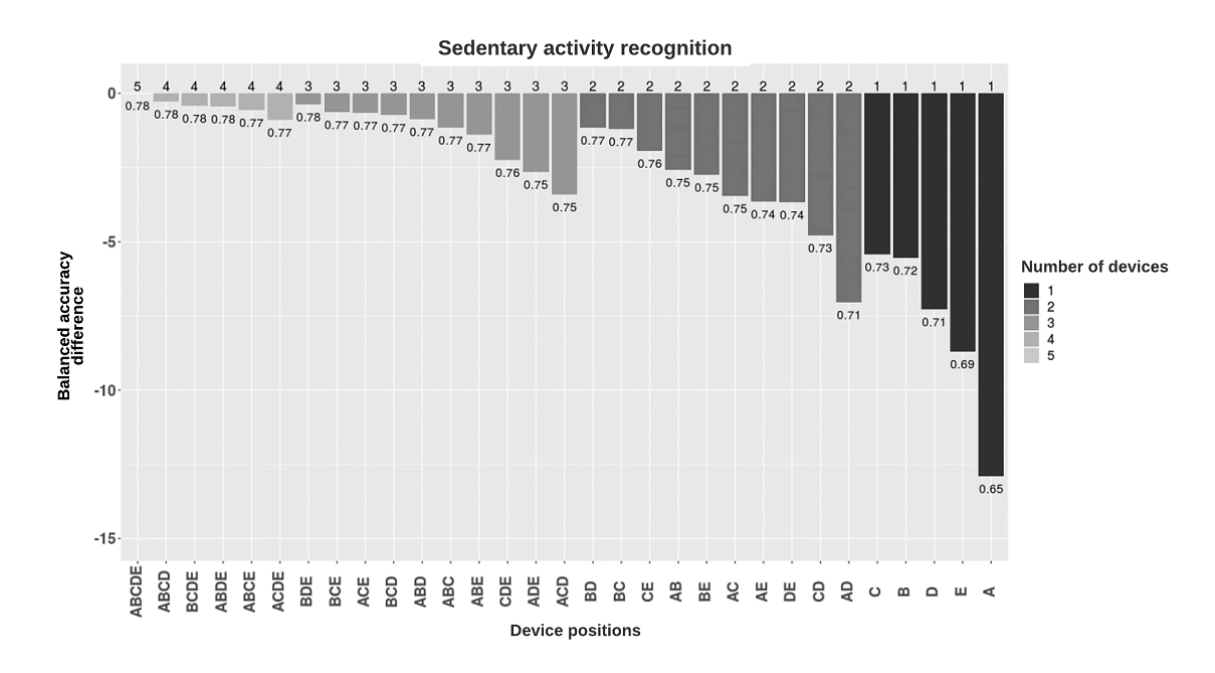
Figure 3. Balanced accuracy performance of sedentary activity classification models based on the device placement combinations. Models were grouped by the number of devices used and, in each group, were sorted by decreasing balanced accuracy (rounded). Y-axis shows the difference between the balanced accuracies of the different combinations and the five-placement combination. Numbers in the plot show the balanced accuracies of each placement combination. A: ankle; B: upper arm; C: hip; D: thigh; E: